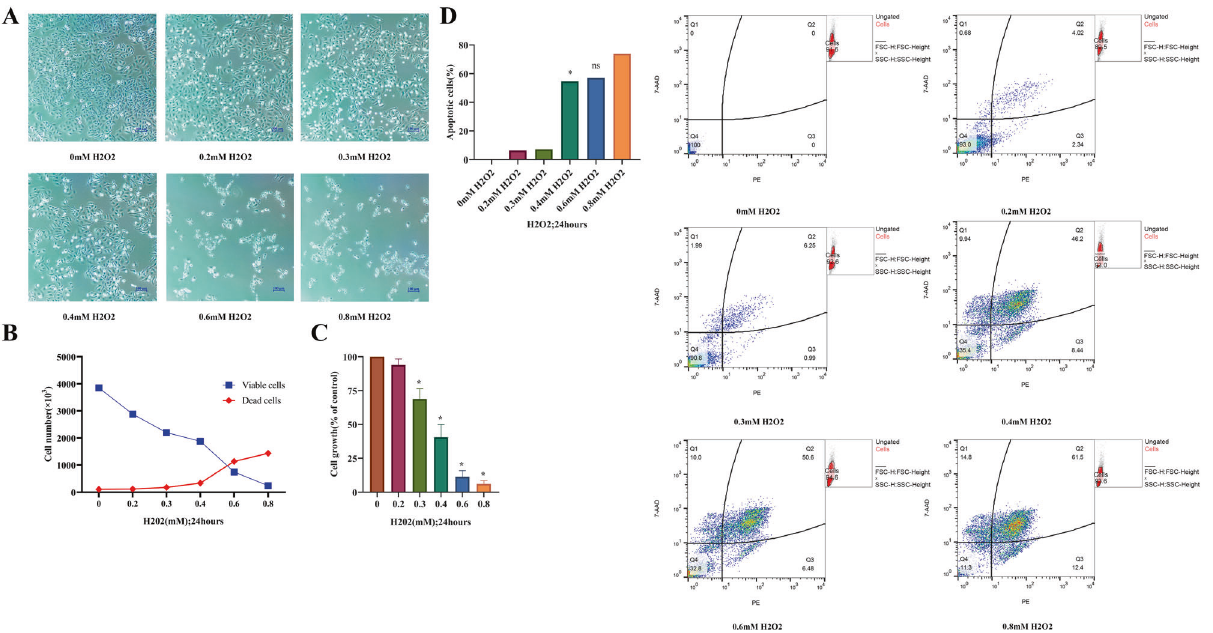
Fig. 2 Cell model establishment. A Microscopic observation of the effect of different concentrations of H 2 O 2 (0 – 0.8 mM) on L02 cells for 24 h (scale bar, 100 µm). B Effect of different concentrations of H 2 O 2 (0 – 0.8 mM) on the number of L02 cells for 24 h. C Growth inhibition of L02 cells by H 2 O 2 was fi rst assessed with the CCK8 assay following treatment with different concentrations of H 2 O 2 for 24 h. D Flow cytometry was performed to examine the effects of various concentrations of H 2 O 2 (0 – 0.8 mM) for 24 h on L02 cell apoptosis. Annexin V-PE/7-AAD double staining and fl ow cytometry. * P < 0.05; ** P < 0.01; *** P < 0.001; **** P < 0.0001; ns not signi fi